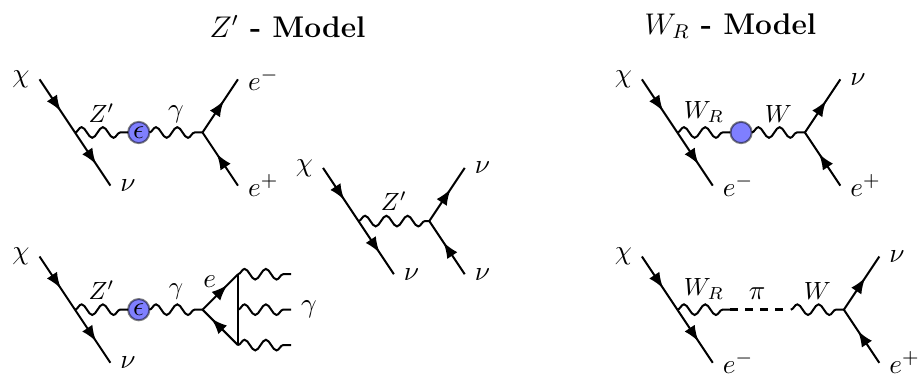
Figure 1 . Most constraining decays for (cid:31) in the neutral current model ( left ) and charged current model ( right